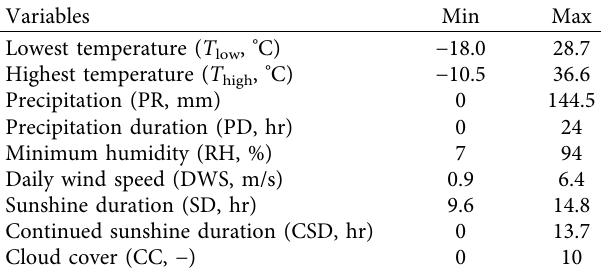
Table 2: The weather variables at initial time.